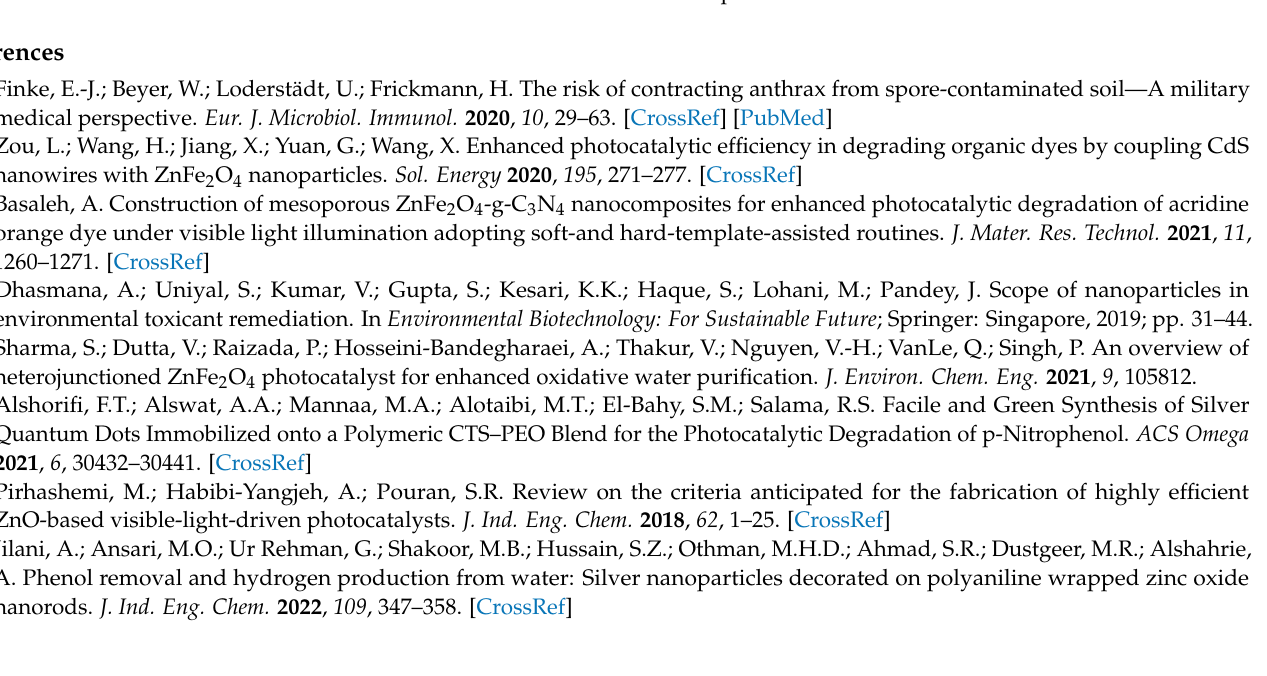
Table S3: Elemental data of ZnO nanoparticles; Table S4: Elemental data of g-C 3 N 4 nanosheets; Table S5: Elemental data of Mn/g-C 3 N 4 /ZnO nanocomposites; Table S6: Elemental data of Ni/g- C 3 N 4 /ZnO